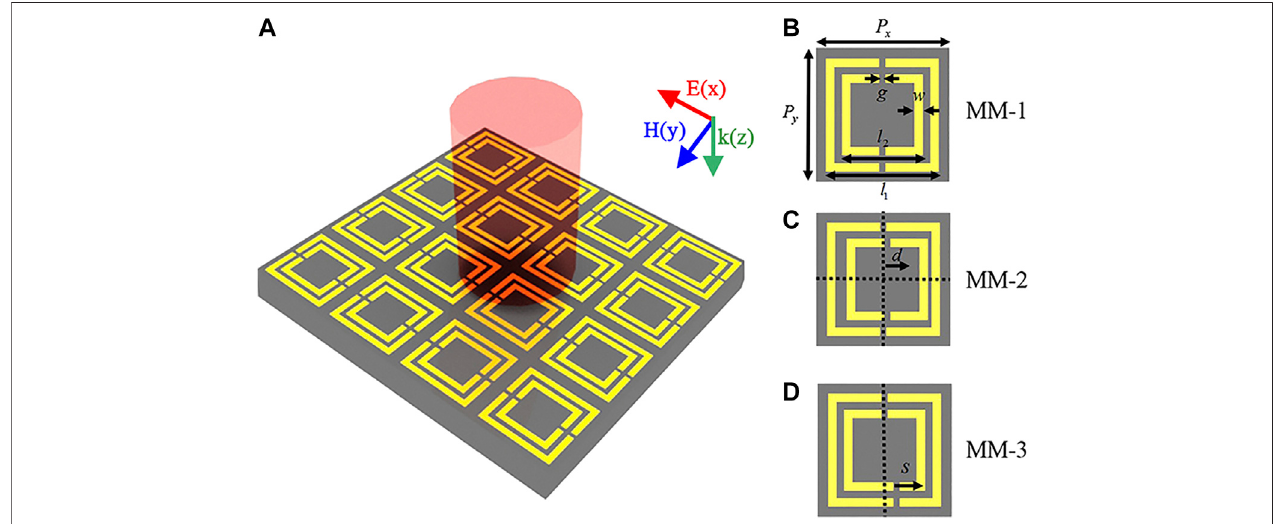
FIGURE 1 | (A) Three-dimensional schematic of the MM structure being excited by a normally incident THz pulse. Two-dimensional schematic of unit cell for (B) symmetricMM structure (MM-1), (C) positionasymmetric MMstructure(MM-2),and (D) gapsasymmetric MMstructure (MM-3)withalldimensionsat amicronscale. In (C) , the position of inner SRR moves rightwards by d along x -axis. In (D) , the lower gaps of two SRRs move rightwards by s along x -axis. All three structures have the same dimension parameters: